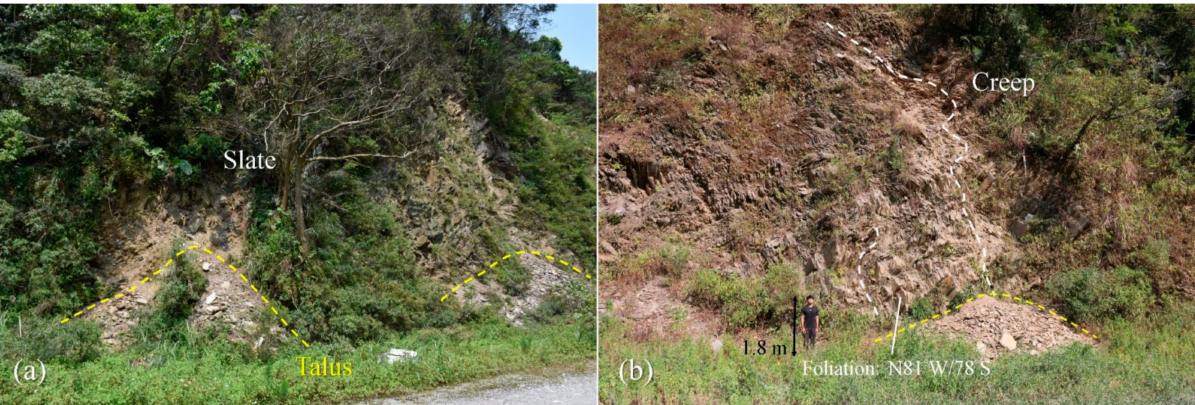
Figure 9. Images taken near the boundary of a slope with a deep-seated gravitational deformation. ( a ) Debris piled-up to form a talus under a scarp. ( b ) A slate twisted with an open